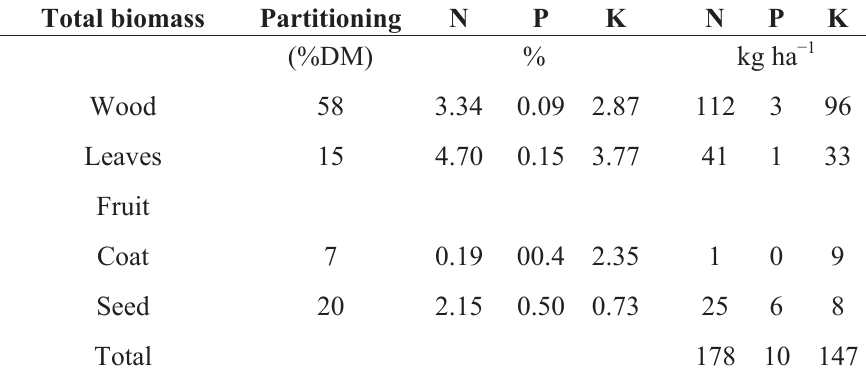
Table 4. Estimated biomass partitioning of jatropha (% of aboveground biomass) and the corresponding N, P and K stocks in the seasonal newly developed parts (estimated at 75% of the total dry weight of standing biomass [39]) of the jatropha plant (percentage and element weigh, kg) [17,39,42,43] based on above ground biomass (DM) of 7.7 t ha (cid:237)(cid:20) including seed yield of 1.52